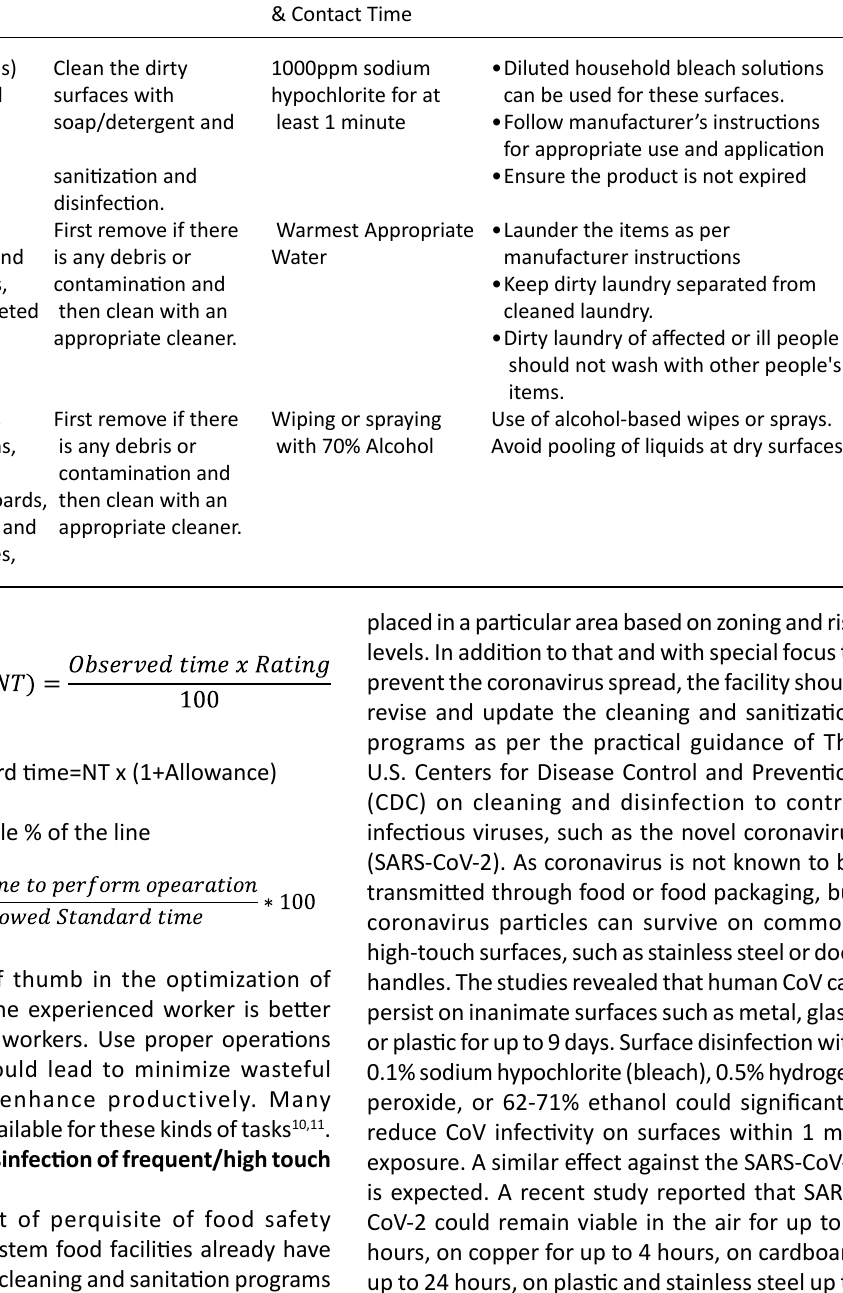
Table 2. Cleaning and disinfection of hard, soft and electronics surfaces Surfaces